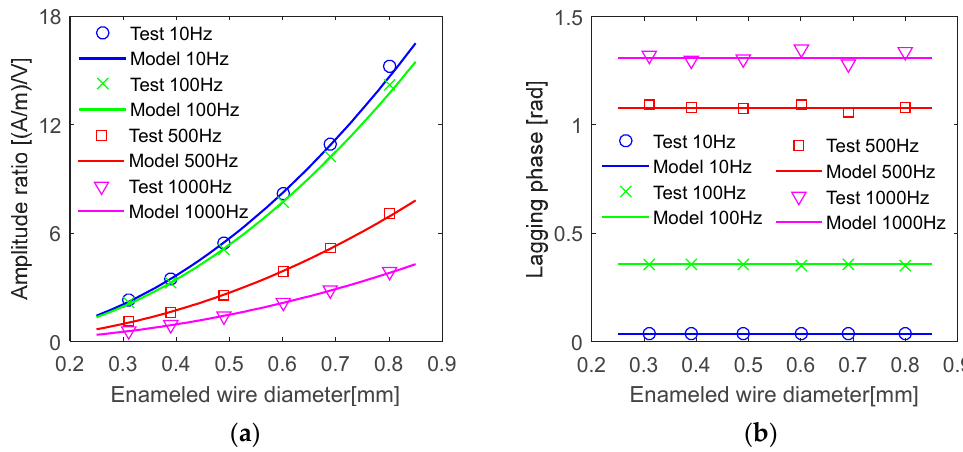
Figure 6. Amplitude ratio and phase lag of the magnetic field under different wire diameters: ( a ) curves of the amplitude ratio vs. enameled wire diameter; ( b ) curves of the phase lag vs. enameled wire diameter.